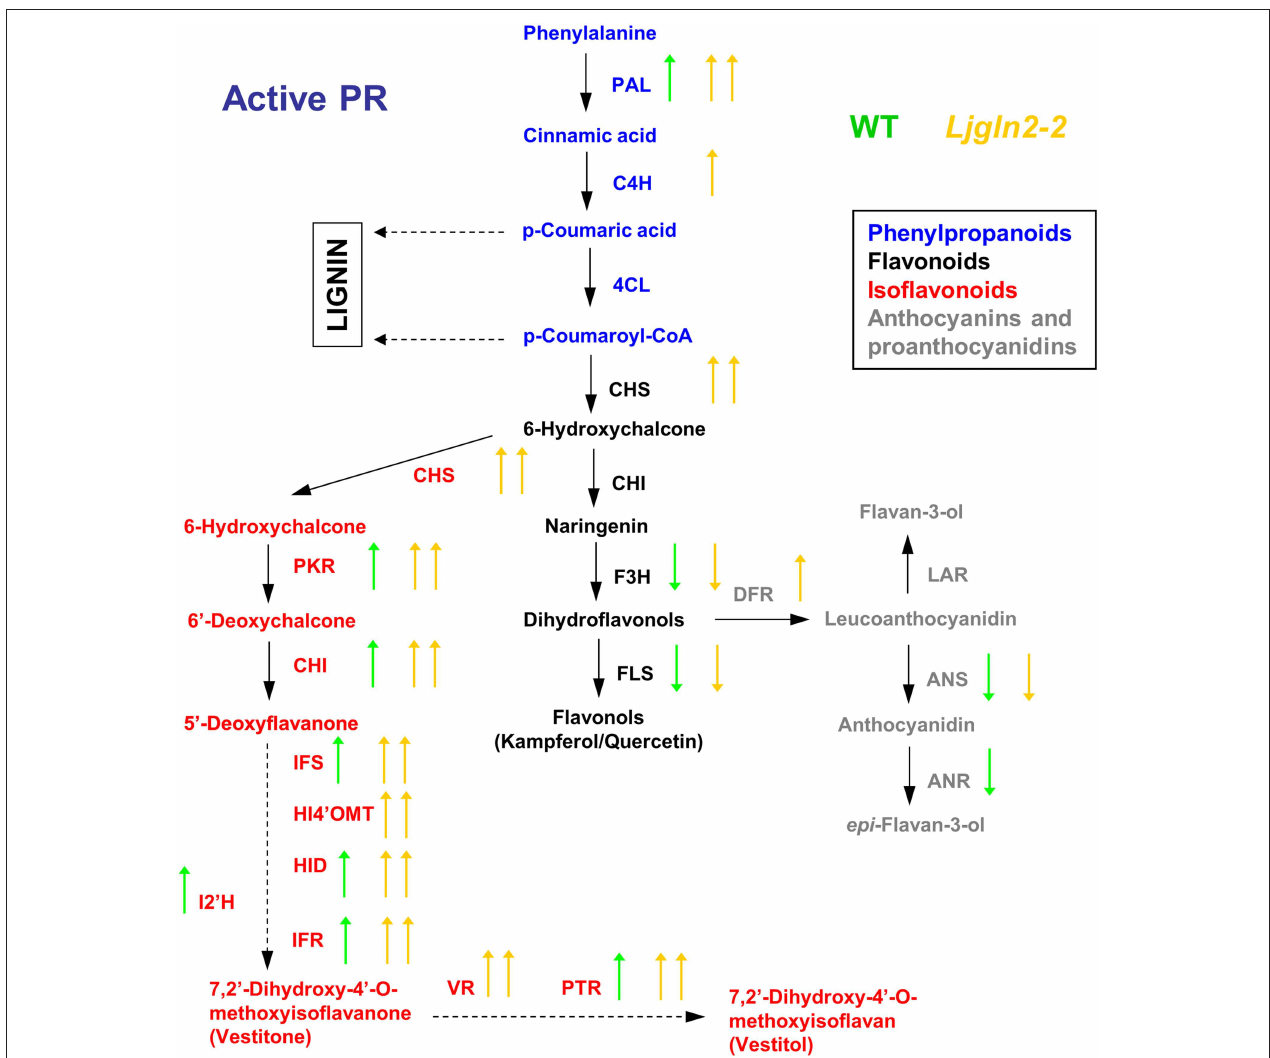
FIGURE 3 | Graphical summary of the changes in the expression of genes for the biosynthesis of phenolic compounds under active photorespiratory conditions. Other details as in the legend of Figure 2